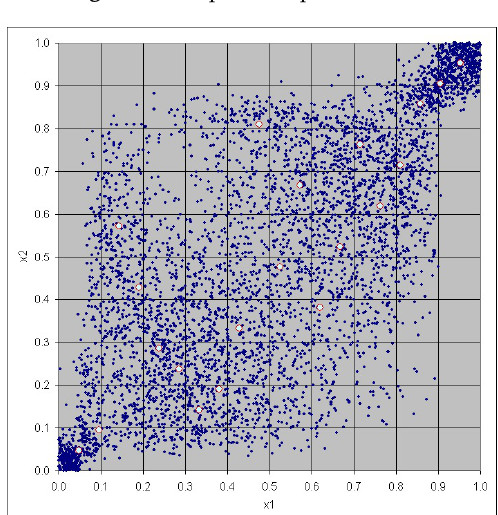
Figure 15. Empirical copula, m = 15.